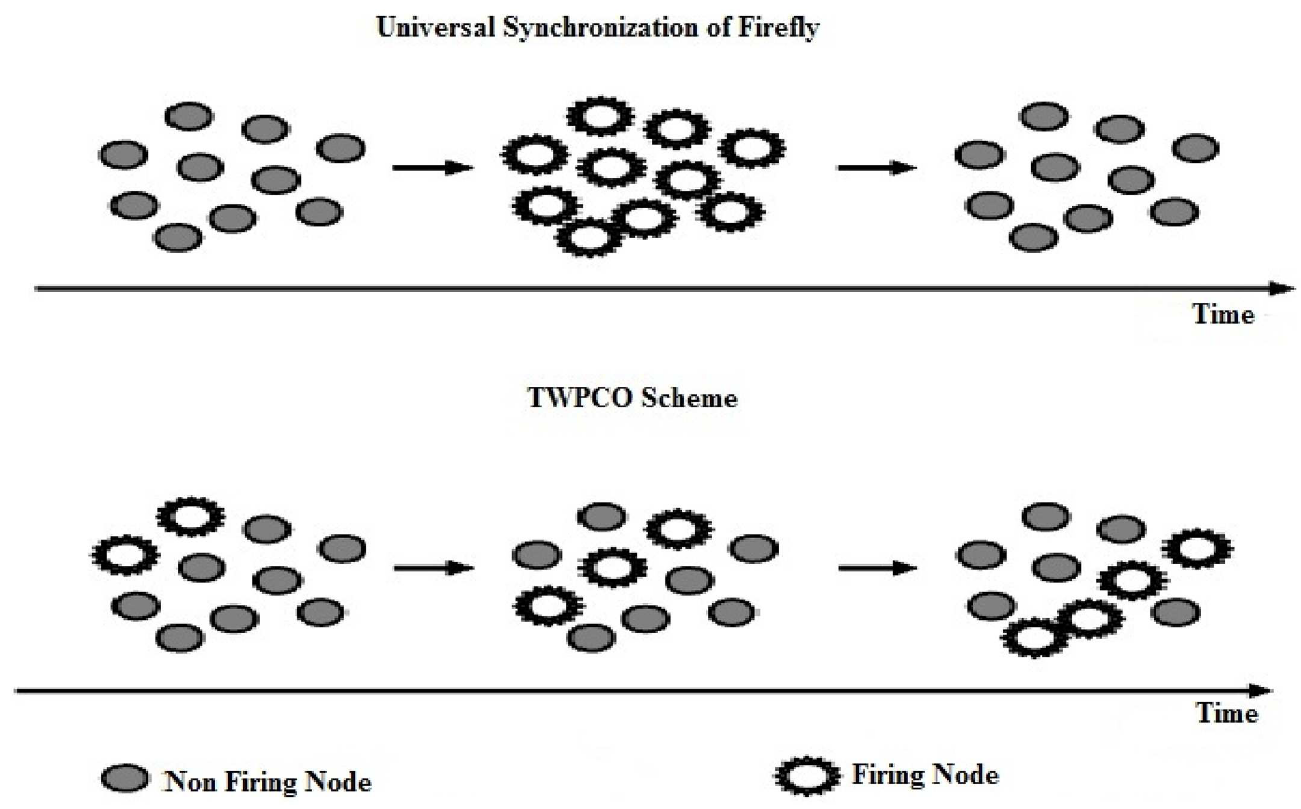
Fig 3. Universalsynchronization and